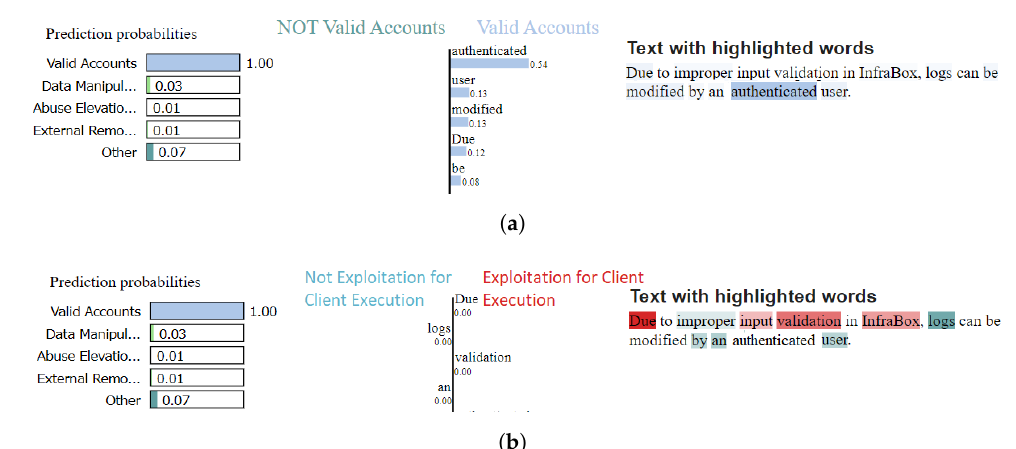
Figure 10. Comparison of word mappings for each technique corresponding to CVE #2 from Table 4. ( a ) Mapping Valid Accounts; ( b ) Mapping Exploitation for Client